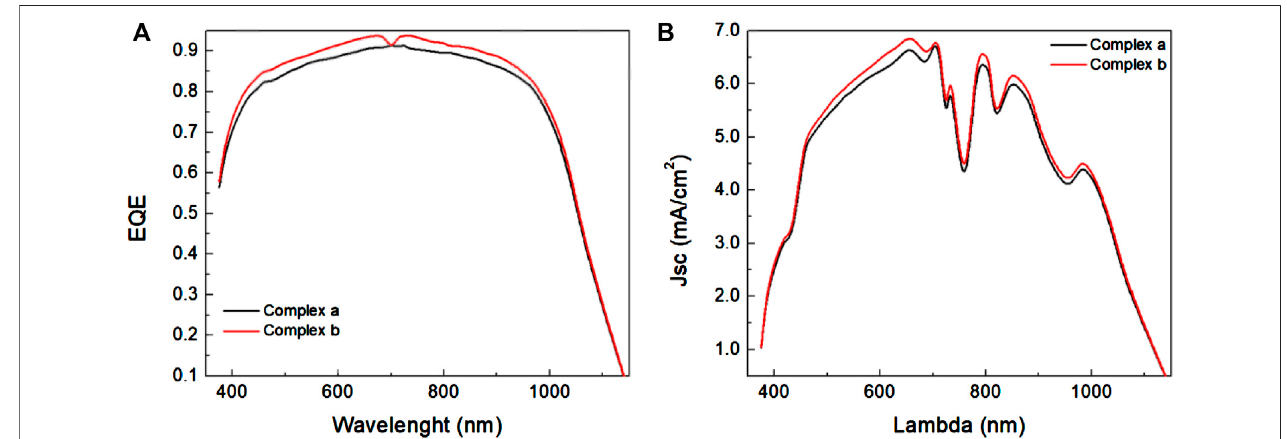
FIGURE 13 | PEDOT:PSS-graphene-a and PEDOT:PSS-graphene-b devices (A) EQE and (B) J sc .